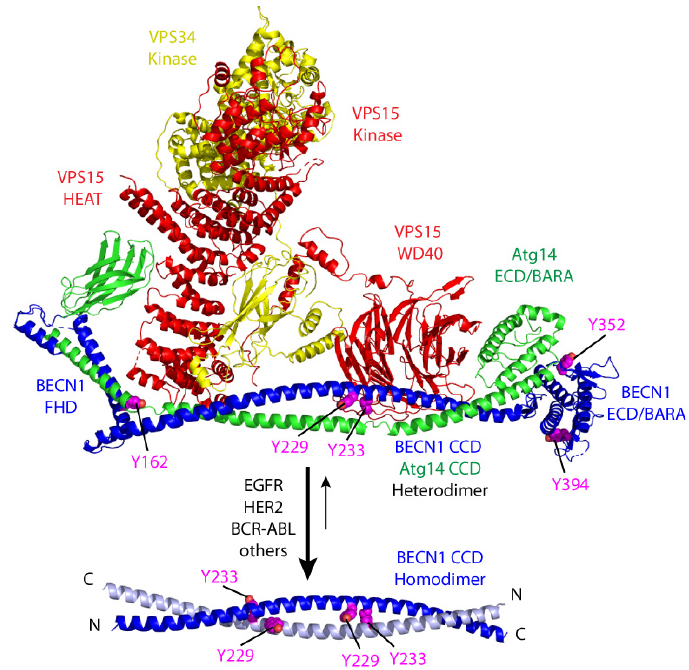
Figure 3. Model of tyrosine phosphorylation modulating the equilibrium between Beclin 1 active CCD heterodimer and inactive CCD homodimer. Human VPS34 complex model above is based on the yeast structure (PDB:5dfz). Complex subunits are colored: VPS15 (PIK3R4) in red, VPS34 (PIK3C3) in yellow, ATG14 in green and Beclin 1 in blue, with Beclin 1 Tyr sidechains in magenta sphere. The heterodimeric Beclin 1-ATG14 CCD cradles the VPS15/VPS34 heterodimer in the complex, with the Y233 sidechain pointing towards the VPS15 beta-propeller, suggesting the phosphorylation state